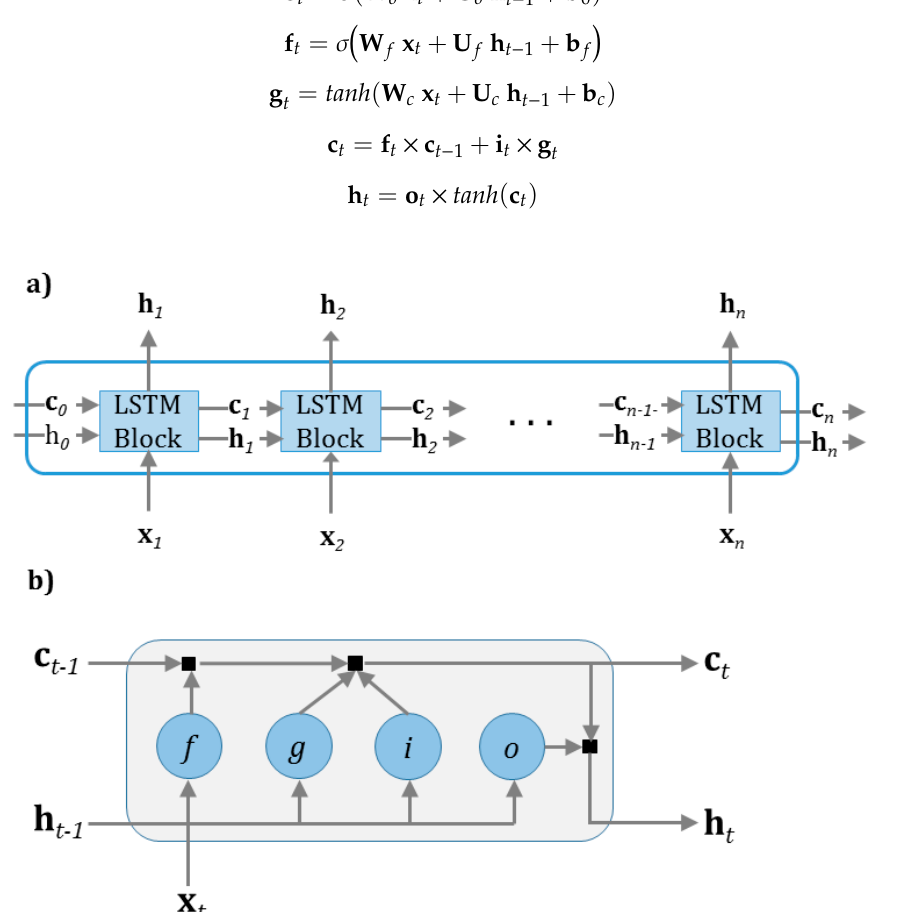
Figure 2. ( a ) Scheme of an unrolled Long-Short Term Memory (LSTM), ( b ) LSTM block structure.